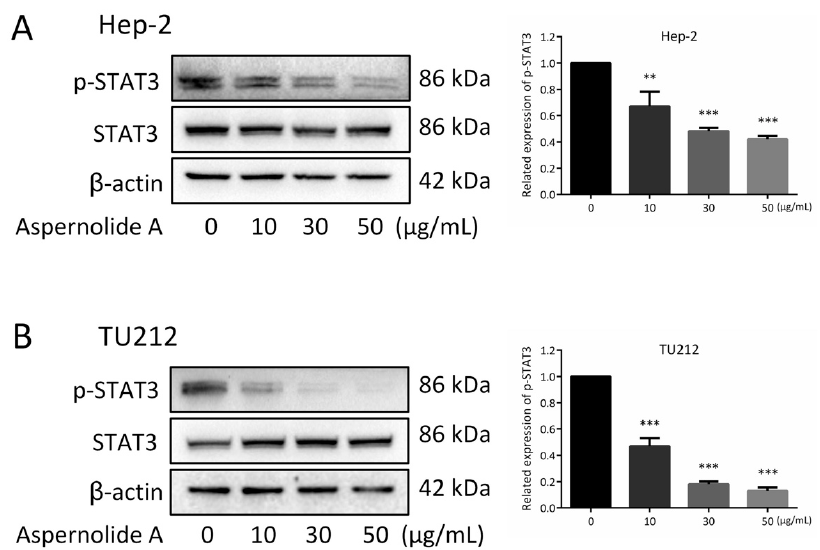
Figure 6. Aspernolide A repressed STAT3 activity in Hep-2 and TU212 cells. ( A , B ) The related expressions of p-STAT3 and STAT3 were detected in Hep-2 and TU212 cells by Western blotting. β -actin was used as a control. (* p < 0.05, ** p < 0.01 or *** p <